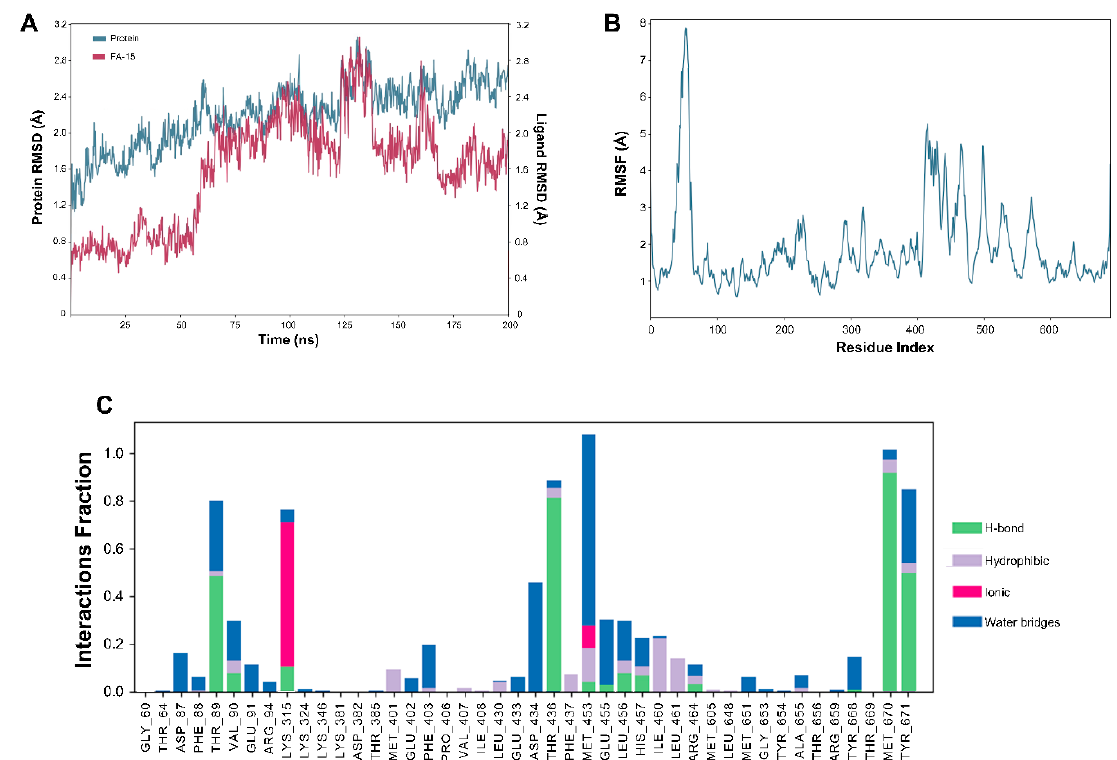
Figure 5. Molecular dynamic simulations of FA-15–EF-G complex: ( A ) root mean square deviation (RMSD) plot, ( B ) root mean square fluctuation (RMSF) plot, and ( C ) protein–ligand contacts.